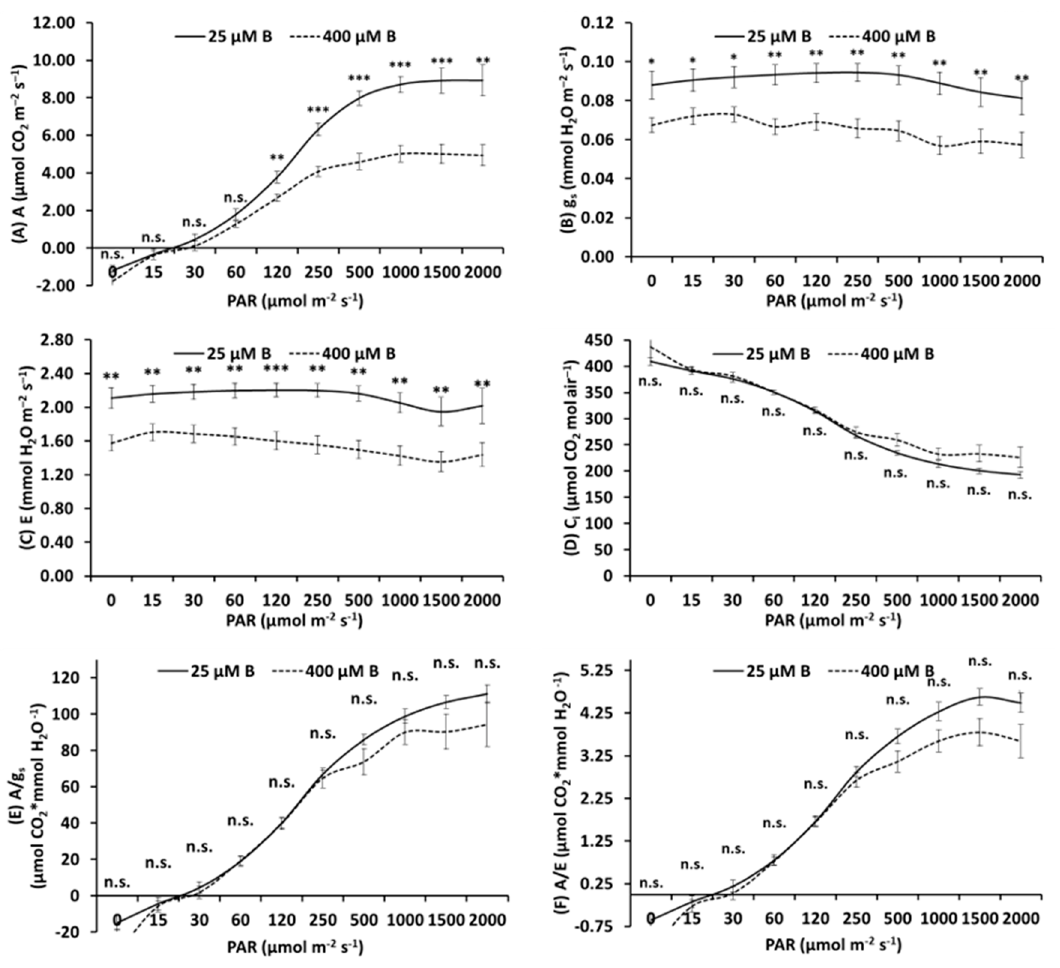
− 2 s − 1 ) ( A ), stomatal conductance (g